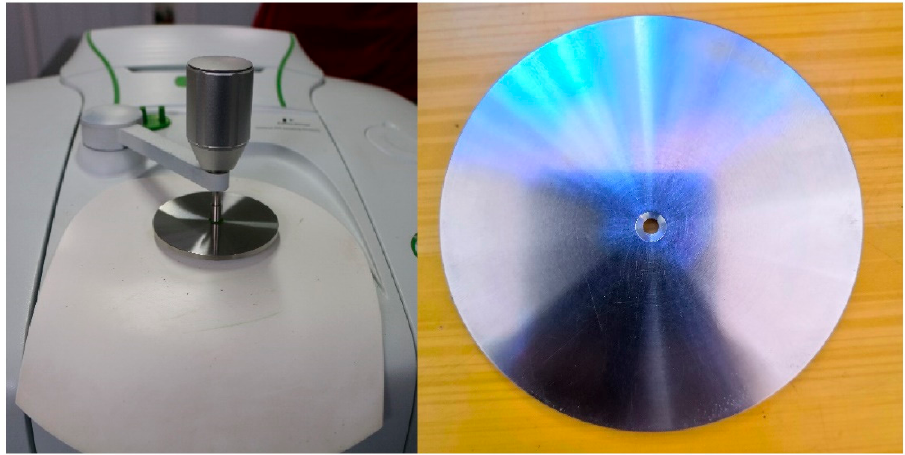
Figure 12. ZnSe ATR accessory (left) and the metal O-ring (right) in the study.